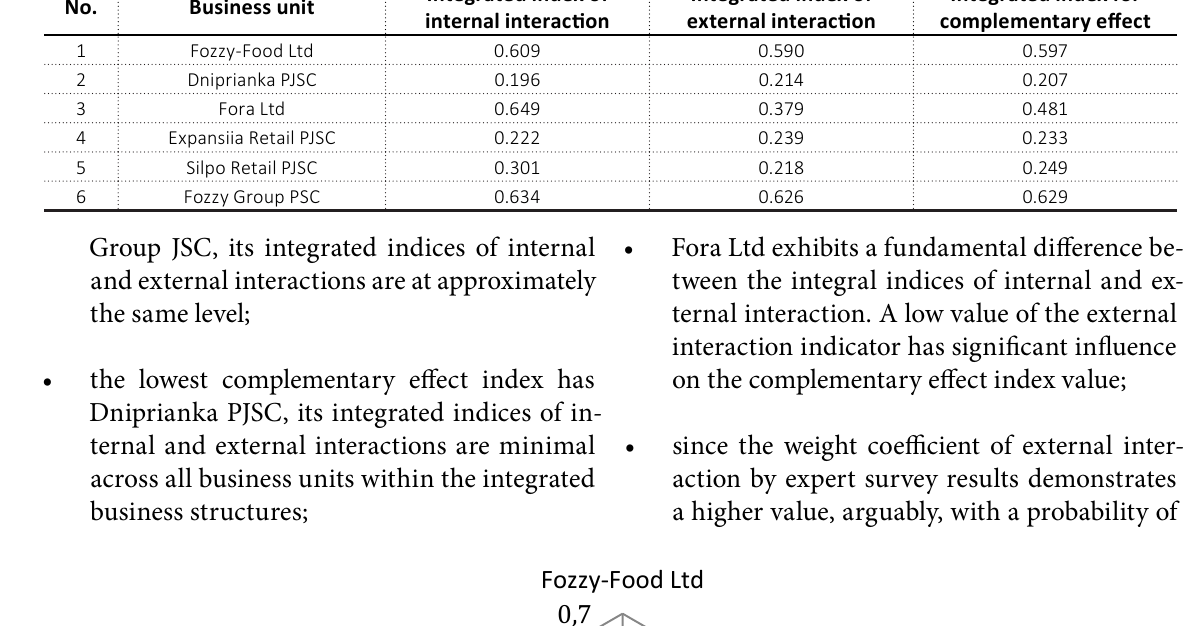
Table 2. Complementary effect index values for Fozzy Group business units No.